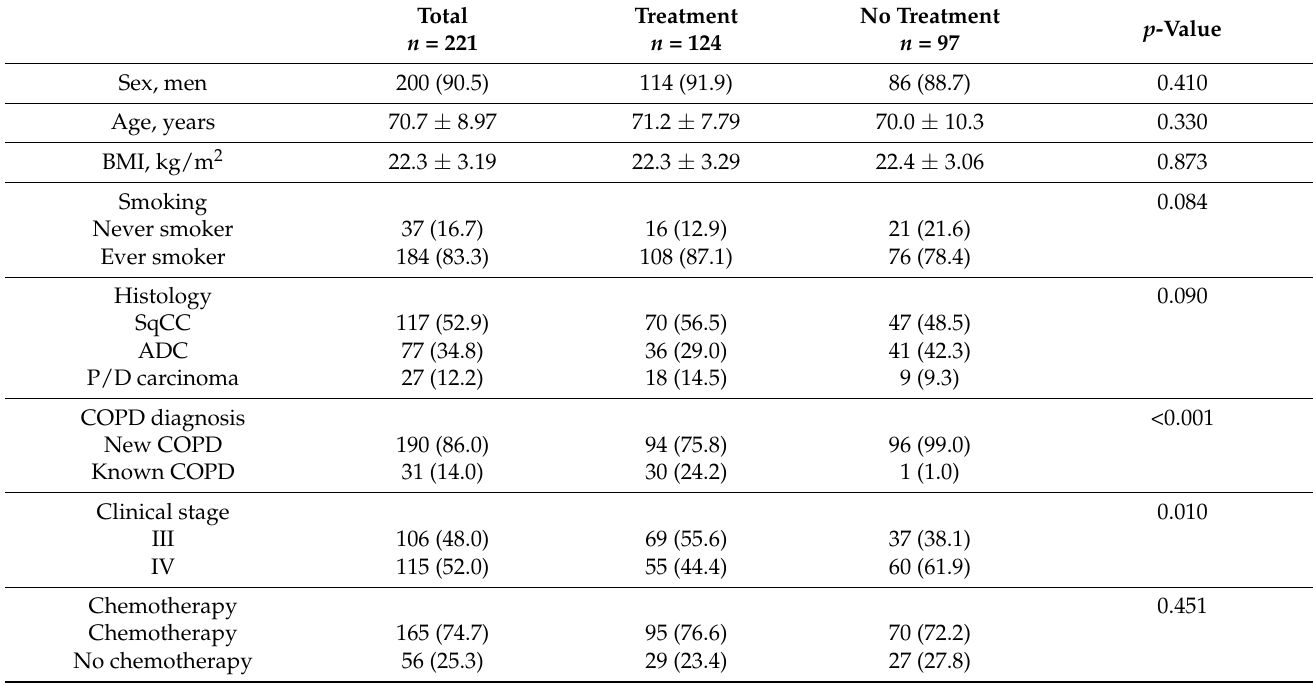
Table 1. Comparison of baseline characteristics by COPD treatment